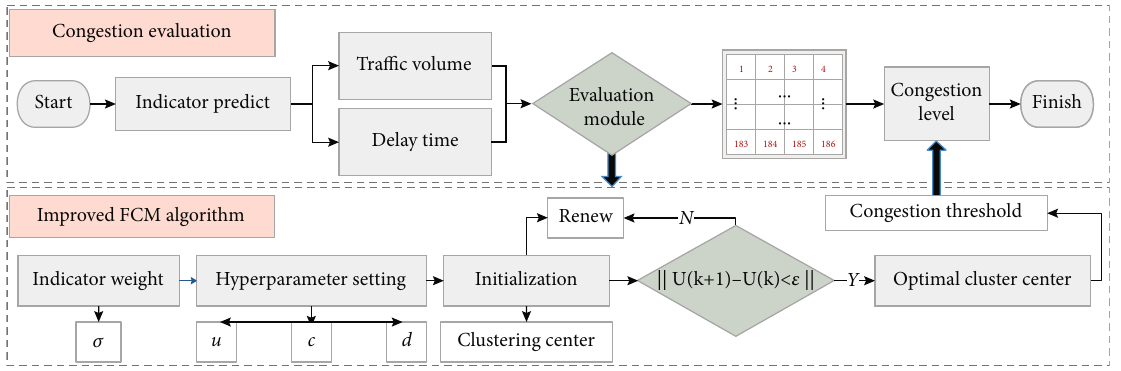
Figure 9: The algorithm fl ow of tra ffi c congestion evaluation.